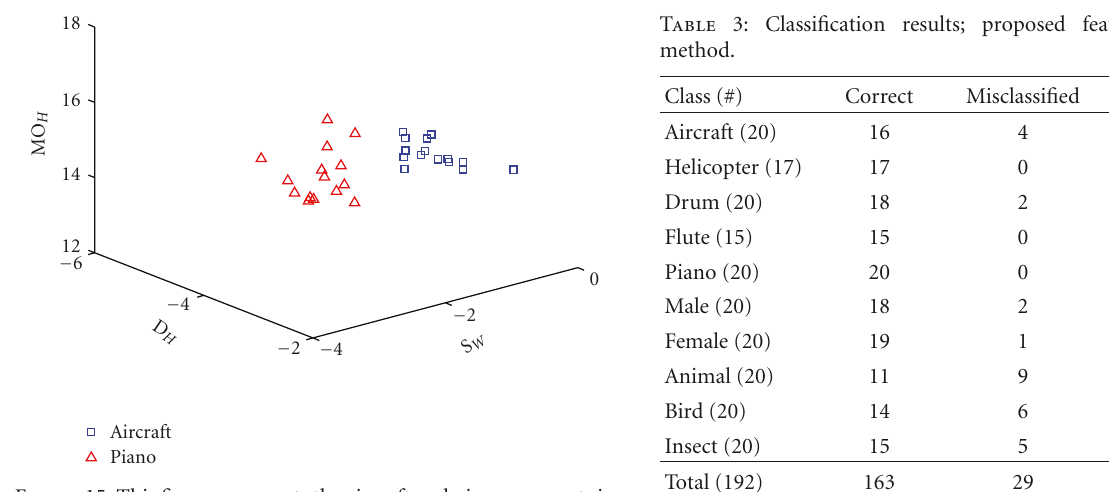
Figure 15: This figure represents the aircraft and piano segments in the feature plane. Since maximum three dimensions of the feature domain can be plotted, only three features of the feature vectors are shown in this figure. MO H , D H , and S W represent the second central moment of coe ffi cient vectors in H , the derivative of coe ffi cient vectors in H , and the sparsity of base vectors in W , respectively. As it can be observed from the feature domain, the feature vectors from aircraft and piano are separate from each other.